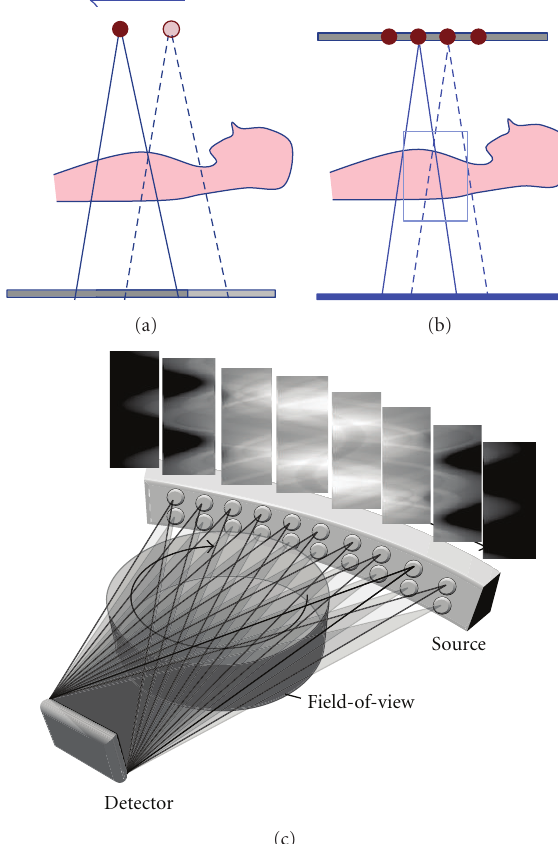
Figure 1: Multi-axial acquisition system concepts: (a) multiple sequential axial scans taken by single source 3rd generation system, (b) a system with multiple sources distributed longitudinally, and (c) a multisource inverse geometry source (MS-IGCT) with 2 by 10 area source. Each subsinogram can be rebinned to conventional 3rd generation